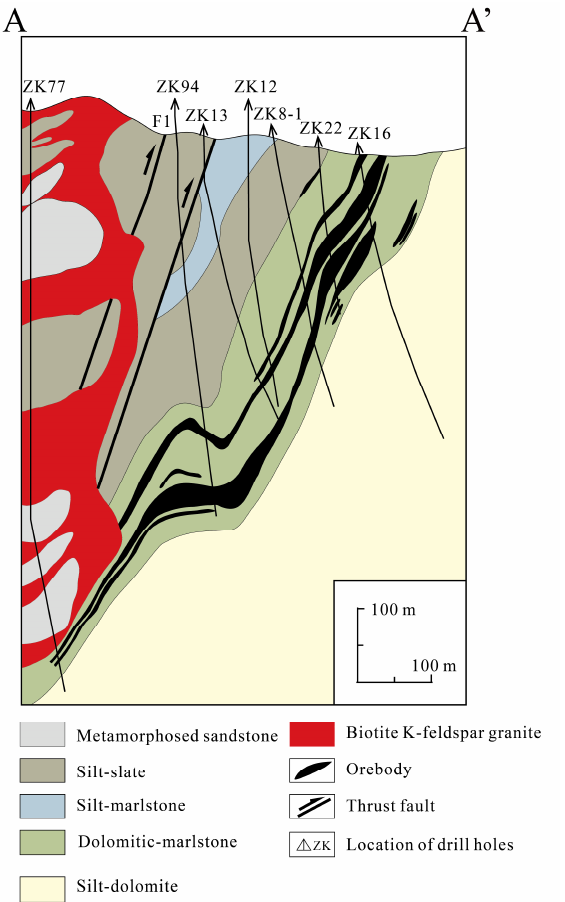
Figure 2. Geological map of the Jiashengpan deposit; modified from [4].